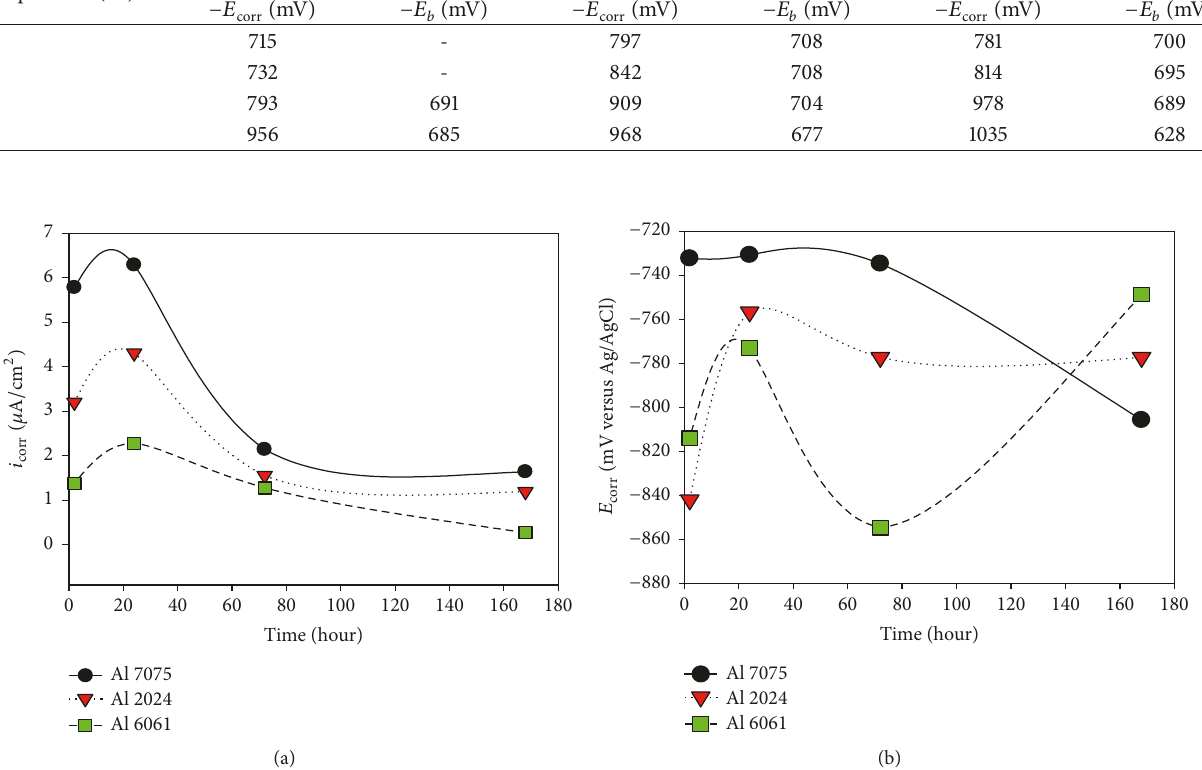
Table 5: Corrosion potential 𝐸 corr (mV) and breakdown potential 𝐸 𝑏 (mV) of aluminum alloys at different temperature. Temperature ( ∘ C)